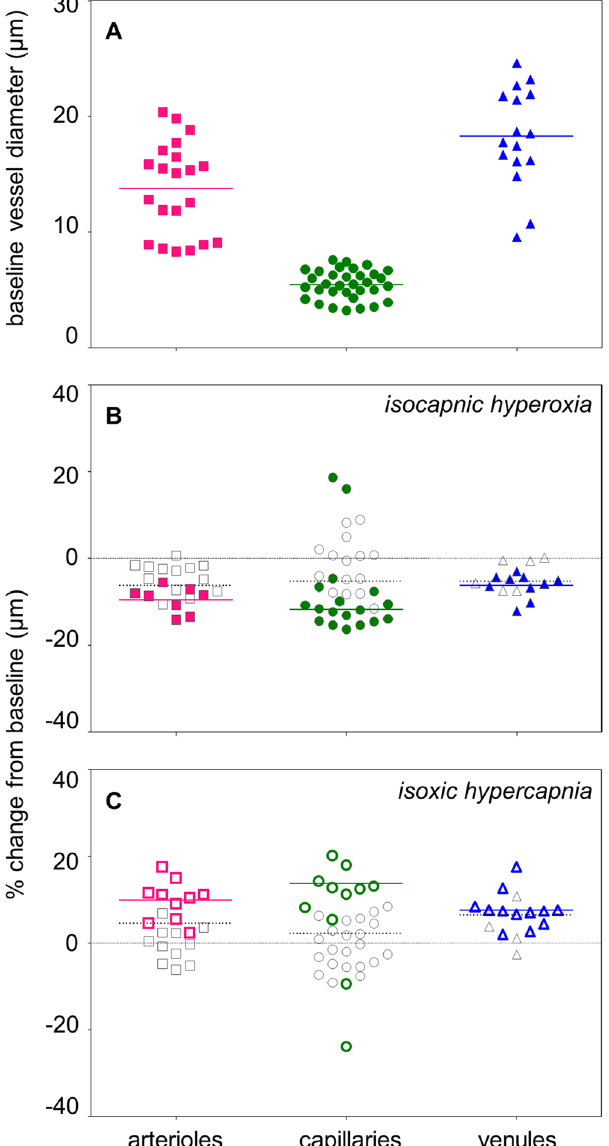
Figure 1. ( A ) Illustrates baseline vessel diameter of all 70 segments analysed (21 were from pre-capillary arterioles, 33 from capillaries and 16 from post-capillary venules). The average vessel width for each vessel type is indicated with a colored solid line (pre-capillary arterioles = 13.8 µ m, capillaries 5.5 µ m and post-capillary venules = 18.3 µ m). ( B ) Average responses of all 70 segments to isocapnic hyperoxia. ( C ) Average responses of all 70 segments to isoxic hypercapnia. For both ( B , C ), colored symbols represent definite responses. Segments classified as non-responders (grey symbols) are included for completeness. The average proportional change of “responders” (colored symbols) is given in a colored solid line, and the average proportional change for all segments of that vessel type is marked with a grey dotted line. Note that the two capillary segments which responded in a direction opposite to expected have not been included in the calculation of average response for “responders”.